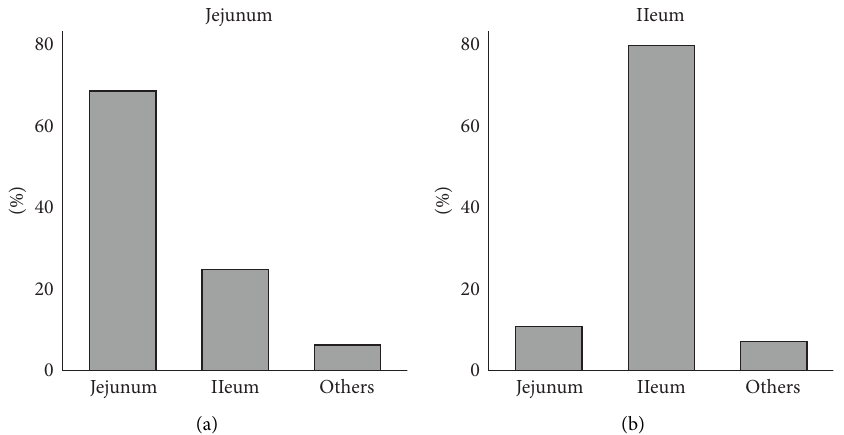
Figure 4: Impaction sites in RGSI patients, (a) with impaction in the jejunum during IGSI and (b) with impaction in the ileum during